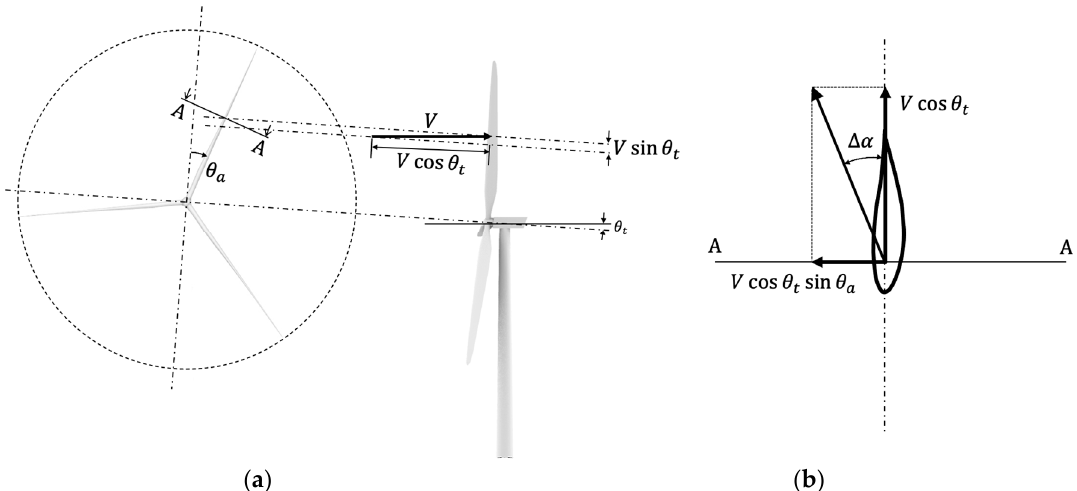
Figure 10. Change of angle of attack due to tilt in a blade rotation. ( a ) Rotor view; ( b ) section view.